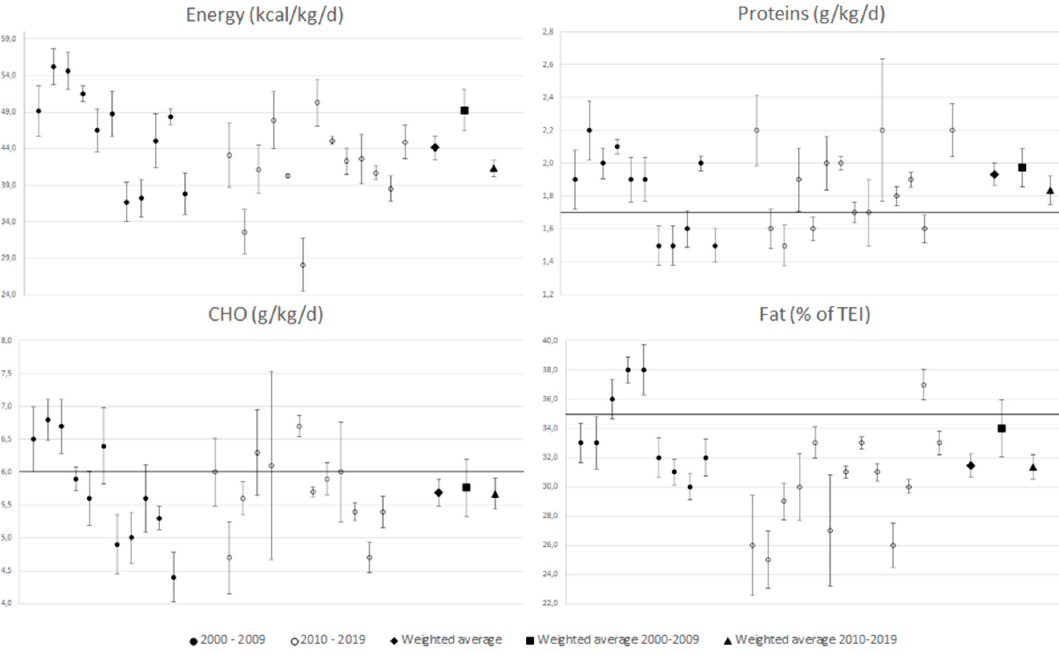
Figure 2. The forest plot for juniors. There are presented studies from 2000–2009 on the left side and from 2010–2019 on the middle and the weighted averages on the right side. Black line demonstrates higher level of recommended value in proteins and fat and lower level in carbohydrate (CHO). If 95% confidence interval (CI) does not cross the line, the result is statistically significant.